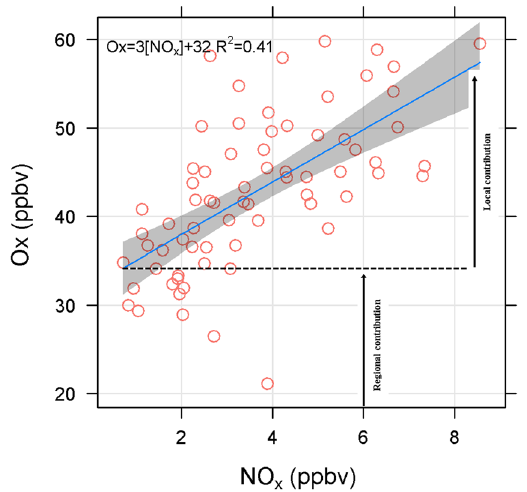
Fig. 3 Ozone (O 3 ) contribution to regional transport. The fi gure shows the correlation between the daylight mean mixing ratio for O 3 + NO 2 (O x ) and that for NO + NO 2 (NO x ). The blue line was obtained by linear regression analysis, and the grey shaded area indicates the con fi dence interval. The intercept gives the contribu- tion of O 3 to regional transport, whereas the slope gives the contribution of primary pollutants 55 . The model is based on sampling performed from 8:00 a.m. to 6:00 p.m. LT